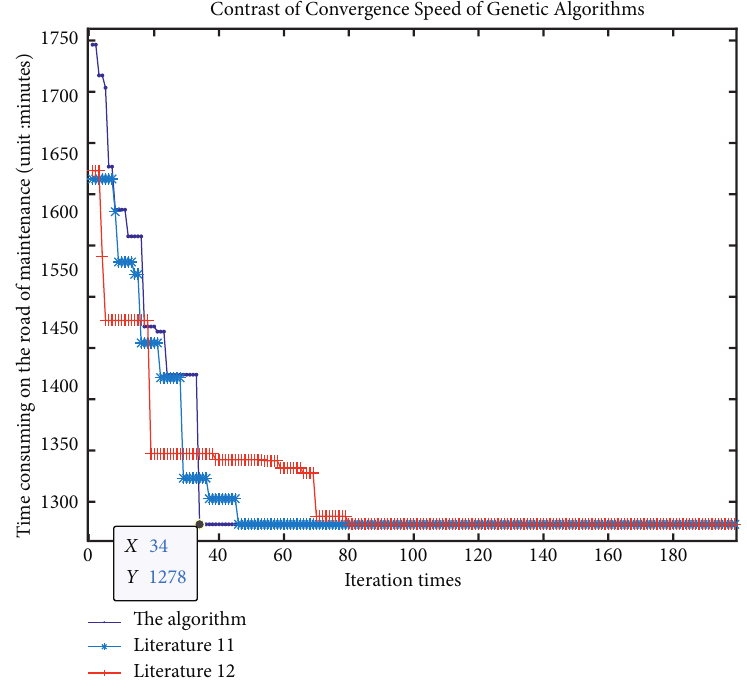
Figure 4: Comparison of convergence speed of genetic